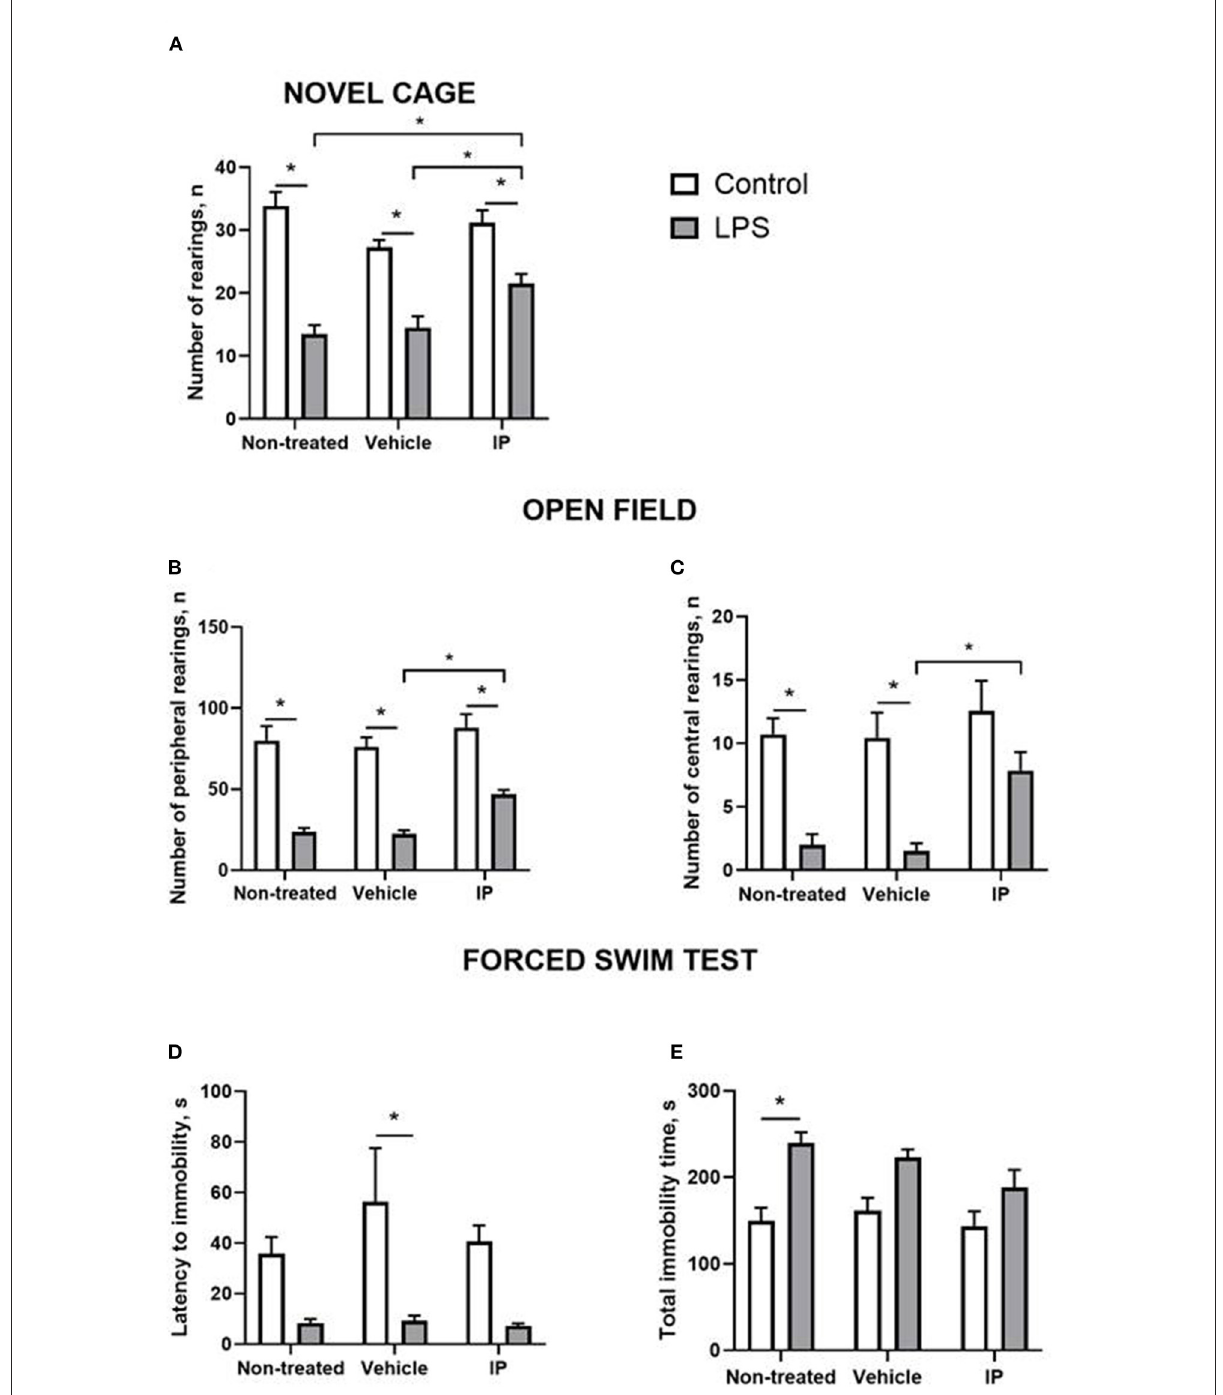
FIGURE4 LPS induces a sickness behavior phenotype, which is partly normalized by the herbal IP. In comparison to non-treated challenged animals, IP-treated LPS-challenged mice displayed (A) a normalized number of exploratory rears, (B) a number of peripheral and (C) central crossings in the open field (two-way ANOVA and Tukey’s test). There were no such differences (D) in the latency to float and (E) duration of the floating in the forced swim test; *vs. the challenged non-treated group. Data presented as mean ±